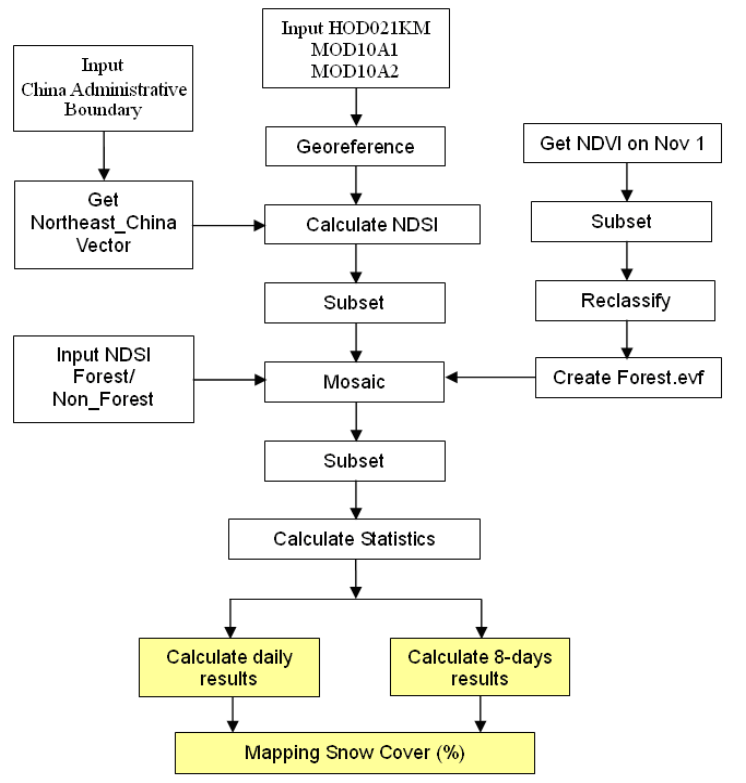
Figure 4. Flowchart for snow cover mapping.